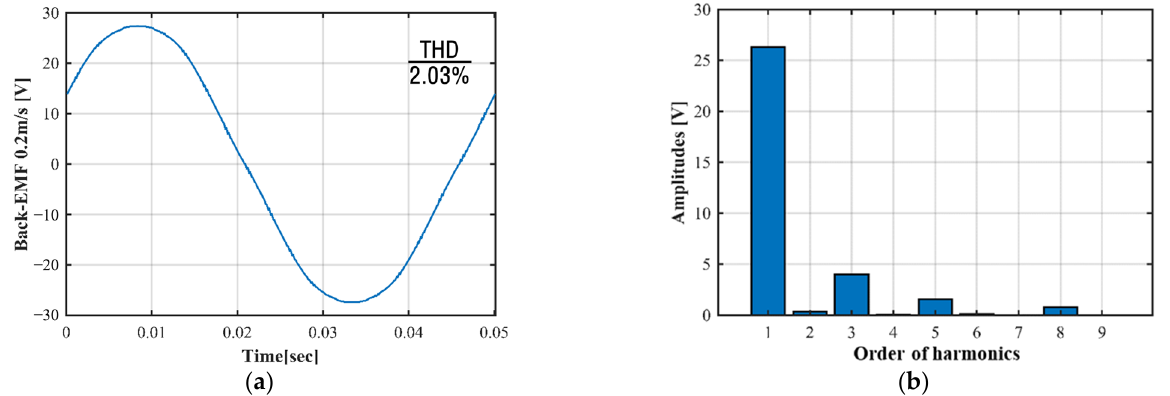
Figure 4. No-load voltage back EMF: ( a ) Back EMF of initial model; ( b ) Harmonic components of back EMF.